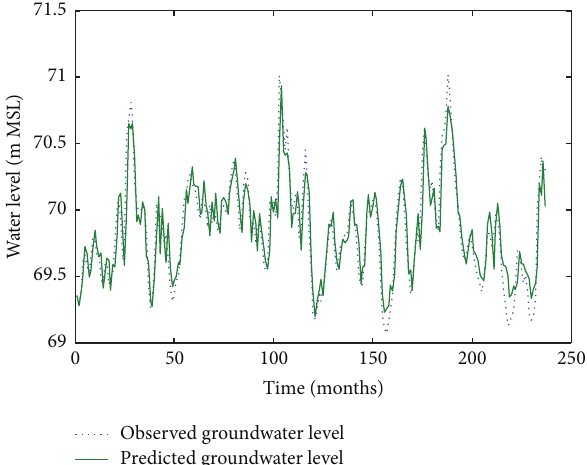
Figure 6: Comparison of observed groundwater levels with sim- ulated results for 1 month ahead using an ANN trained with the Levenberg–Marquardt algorithm (Pp 930).